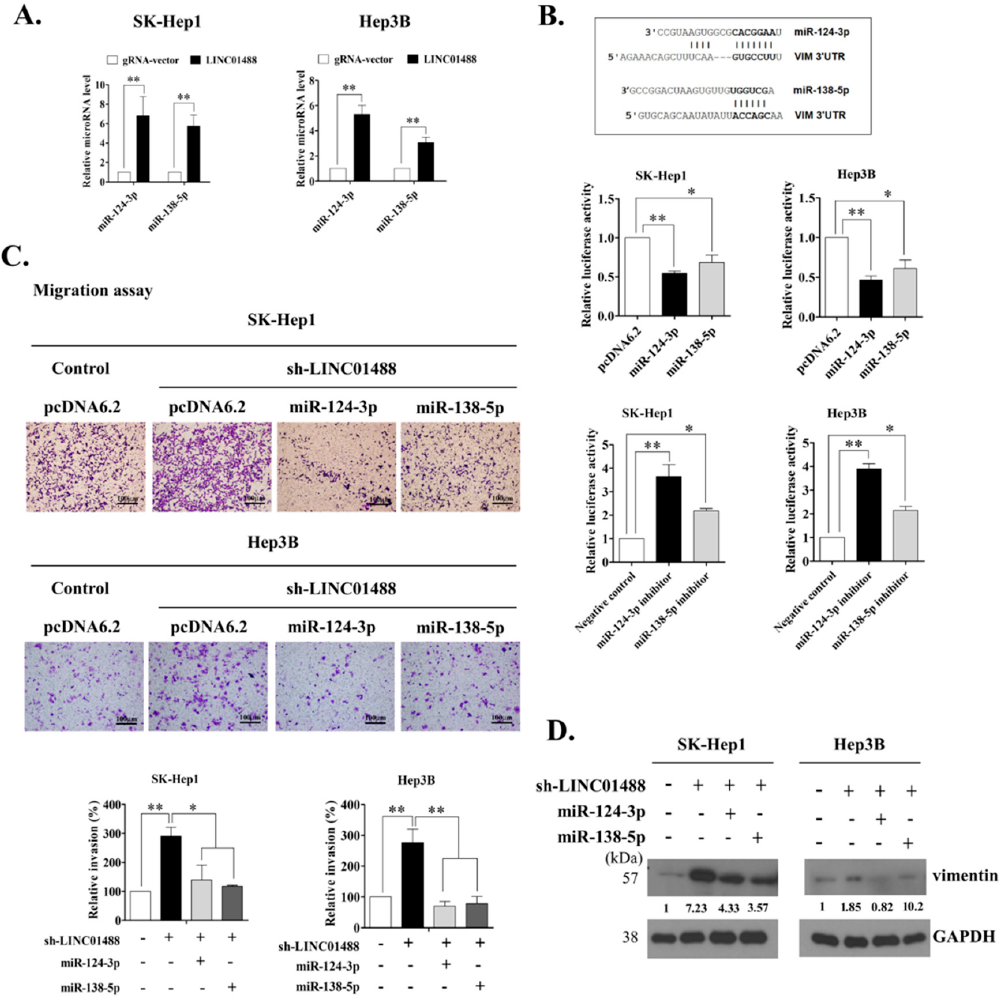
Figure 5. LINC01488 modulates miR-124-3p / miR-138-5p levels to suppress metastasis via targeting vimentin. ( A ) Increased miR-124-3p and miR-138-5p mRNA levels in LINC01488-overexpressing SK-Hep1 and Hep3B cells analyzed via q-RT-PCR. ( B ) MiR-124-3p and miR-138-5p target sequences on vimentin (top panel). Control (pcDNA6.2), miR-124-3p- or miR-138-5p-overexpressing SK-Hep1 or Hep3B cells were transfected with vimentin 3 (cid:48) -UTR, and luciferase activity calculated as fold change relative to control cells (middle panel). Negative control, miR-124-3p inhibitor or miR-138-5p inhibitor were additionally co-transfected with vimentin 3 (cid:48) -UTR in SK-Hep1 and Hep3B cells, and luciferase activity calculated as fold change relative to negative control cells (bottom panel). ( C ) E ff ects of miR-124-3p- or miR138-5p overexpression in LINC01488-depleted SK-Hep1 or Hep3B cells on cell migration and invasion assayed using the Transwell method. ( D ) Western blot analysis of vimentin protein levels in miR-124-3p-, miR-138-5p or LINC01488-depleted SK-Hep1 or Hep3B cells using GAPDH as the loading control. Data are presented as means ± SD (* p < 0.05; ** p < 0.01). 3.7. LINC01488 Suppresses Metastasis and Tumorigenesis of Hepatoma In